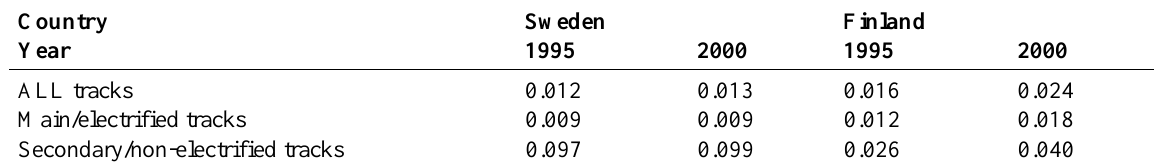
Table 1. Marginal cost in €/100 gross ton km for Swedish and Finnish railroads Country Sweden Finland Year 1995 2000 1995 2000 ALL tracks 0.012 0.013 0.024 Main/electrified tracks 0.009 Secondary/non-electrified